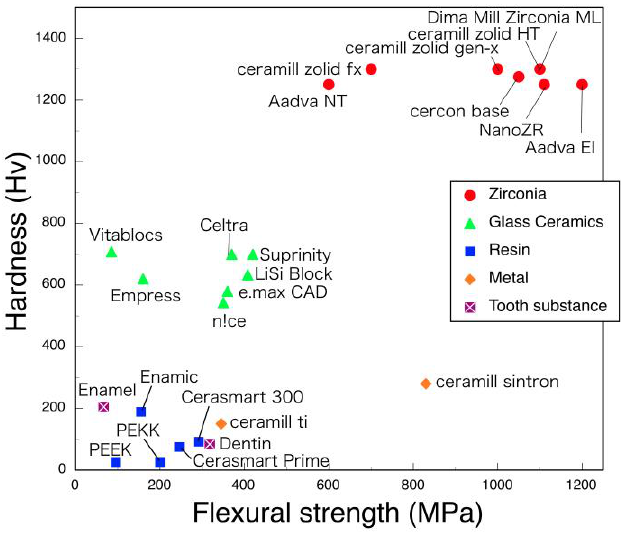
Figure 11. Relation between flexural strength and hardness of tooth substance and CAD/CAM materials. Adopted from manufacturers indication.